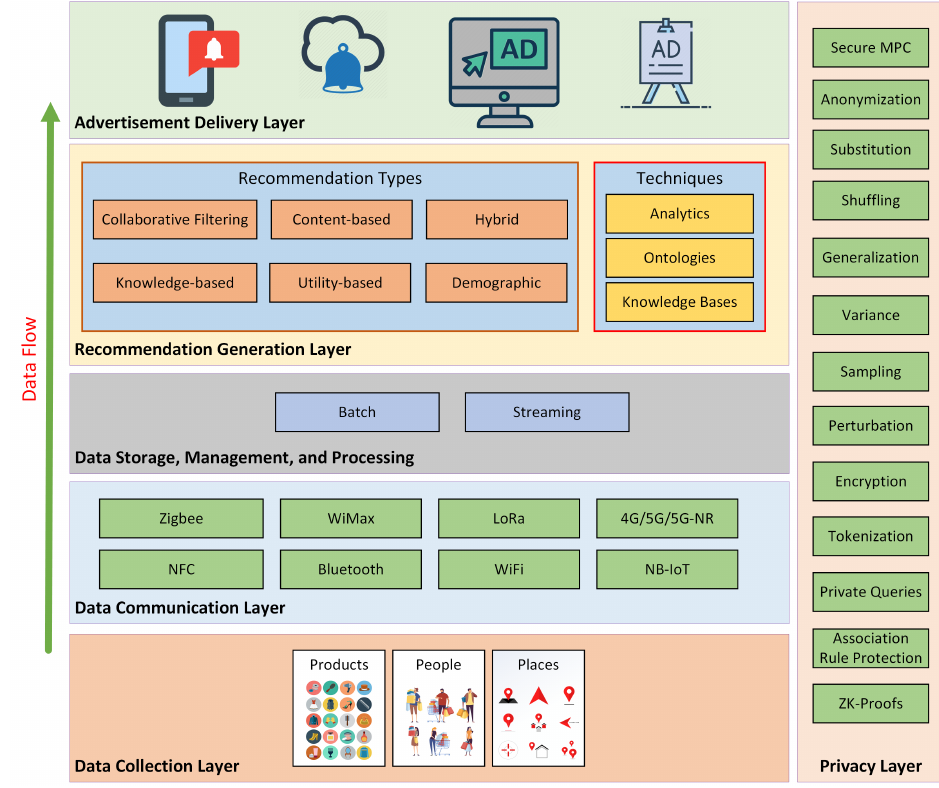
Figure 3. A blueprint layered architecture for IoT advertising